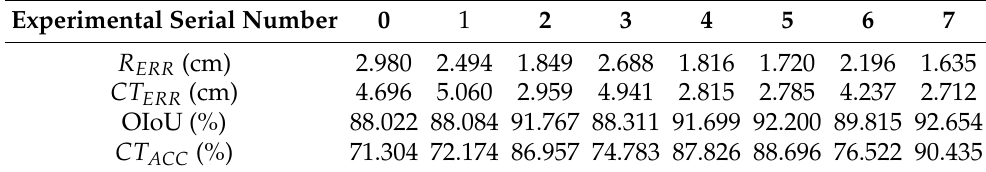
Table 5. Ablation study results for the test